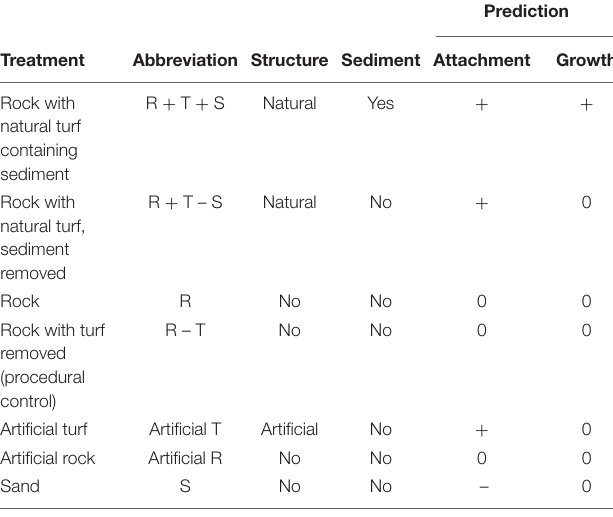
TABLE 2 | Substrate treatments and